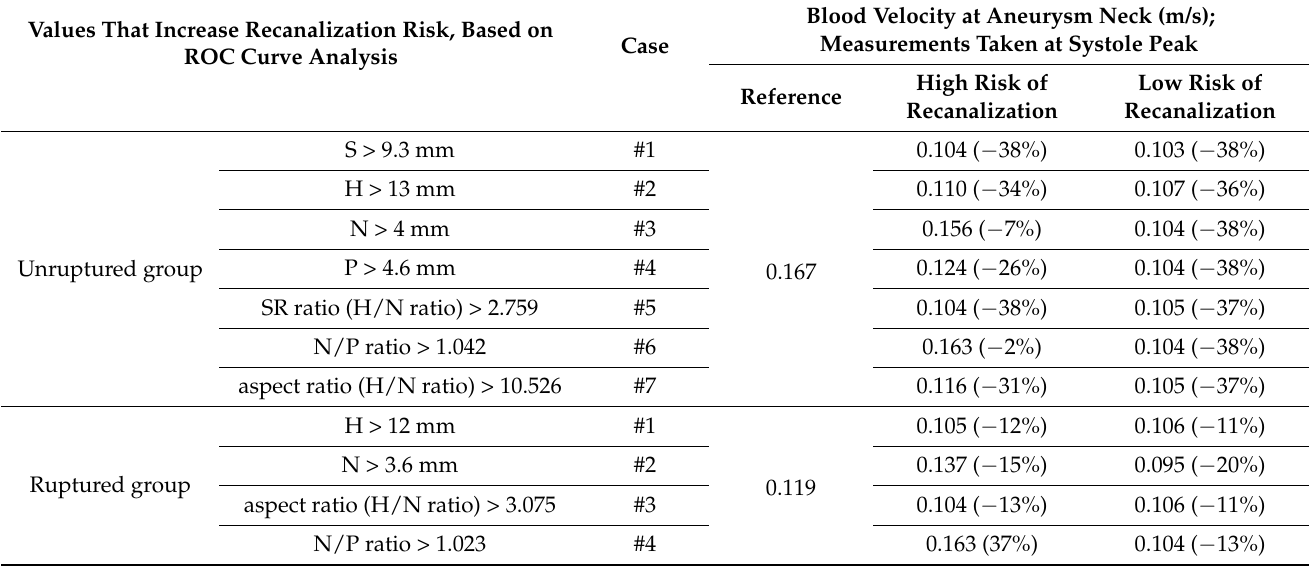
Table 6. Area-averaged velocity at aneurysm neck cross-section in each investigated case study. # case study. Values That Increase Recanalization Risk, Based on ROC Curve Analysis